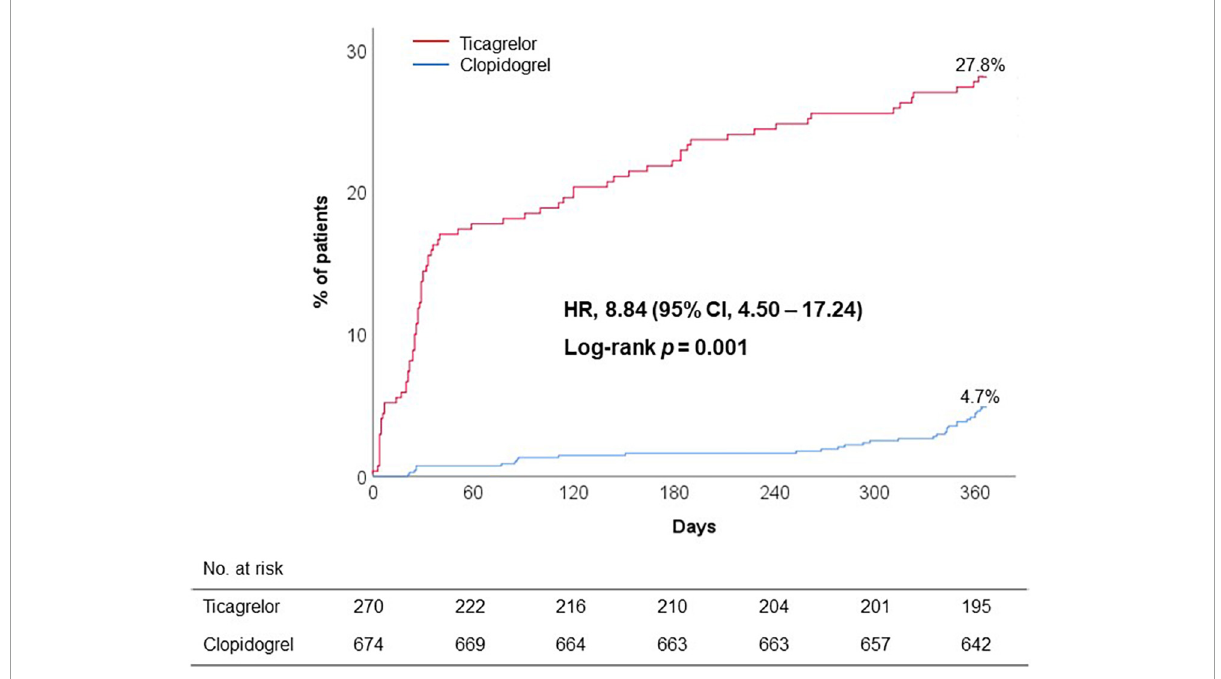
FIGURE2 Premature discontinuation of initial DAPT regimen. CI, confidence interval; DAPT, dual antiplatelet therapy; HR, hazard